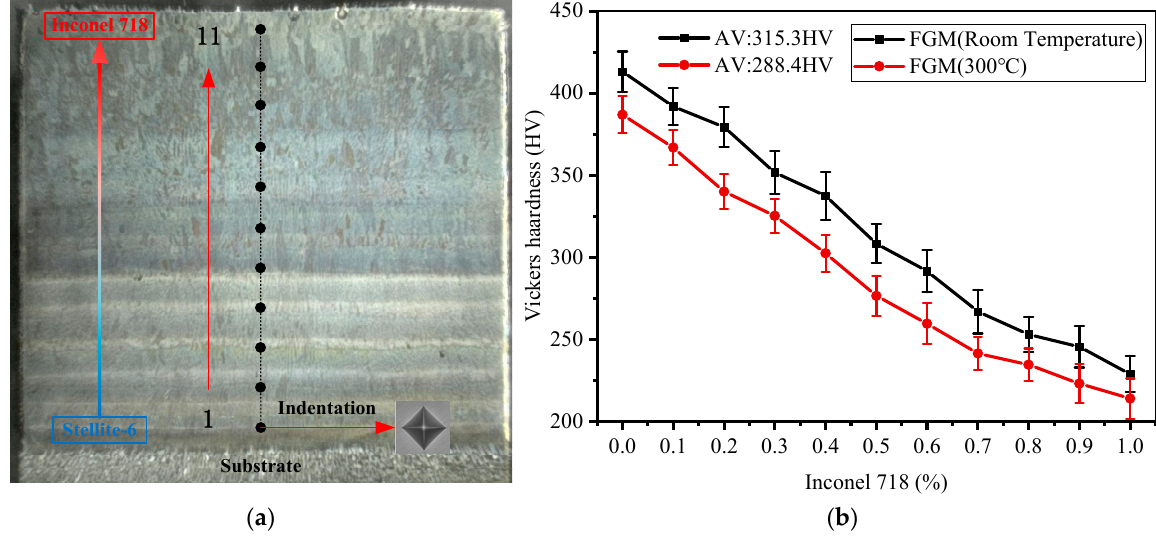
Figure 14. ( a ) Hardness test points on longitudinal section of FGM thin-walled parts; ( b ) Vickers hardness results at the test point.